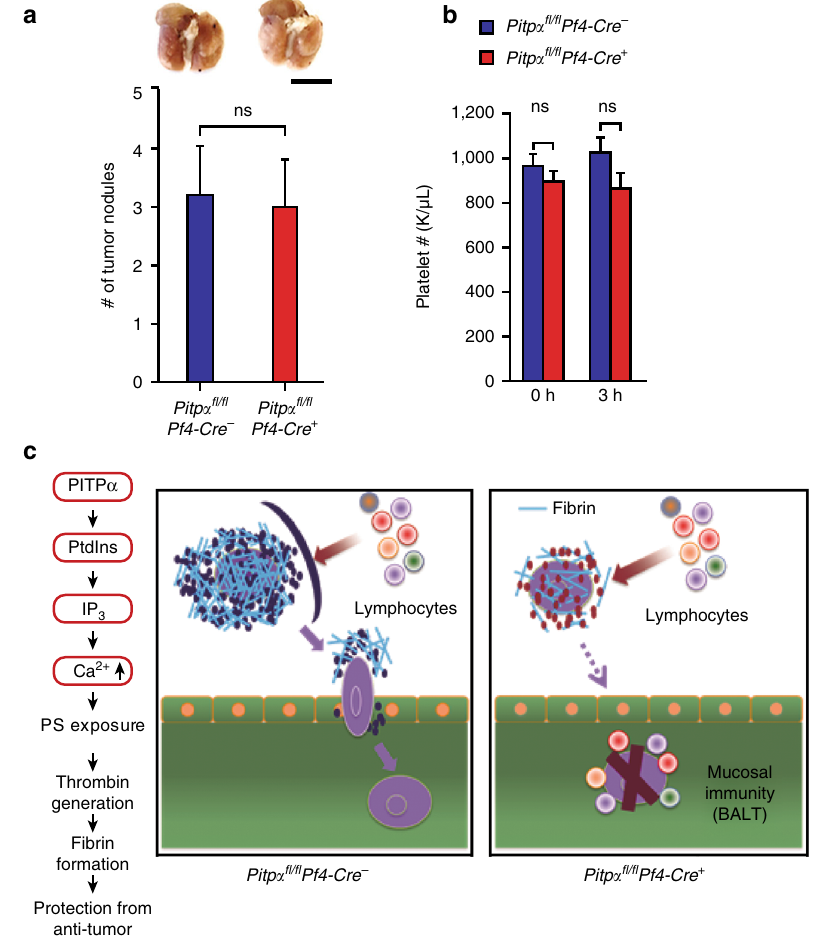
Fig. 6 Coagulation inhibitor NAPc2 inhibits lung tumor metastasis in control mice. a Co-injection of tumors with coagulation factor VIIa inhibitor (NAPc2) reduced lung tumor metastasis in both groups checked 2 weeks after tumor injection ( n = 10 per group). Scale bar = 1 mm. b Platelet counts at 3 h after injection of tumor cells together with coagulation factor VIIa inhibitor NAPc2 ( n = 5 of each group). Shown are the means ± s.d. for a , b , and all statistical analysis was performed using an unpaired Student ’ s t -test. c A model of the sequential events that lead to protection of tumor cells from the immune system. Normal platelets rapidly adhere to the surface of tumor cells. This interaction facilitates prothrombinase assembly on the cell surface, thrombin formation, and the deposition of fi brin. This forms a shroud that protects the tumor from lymphocyte-mediated cytotoxicity. The platelets that coat the tumor cells also facilitate the adhesion and invasion involved in metastasis. However, platelets lacking PITP α adhere poorly to tumor cells, fail to stimulate thrombin generation, and reduce fi brin deposition. This allows the tumor cells to be vulnerable to lymphocyte-mediated cytotoxicity (such as